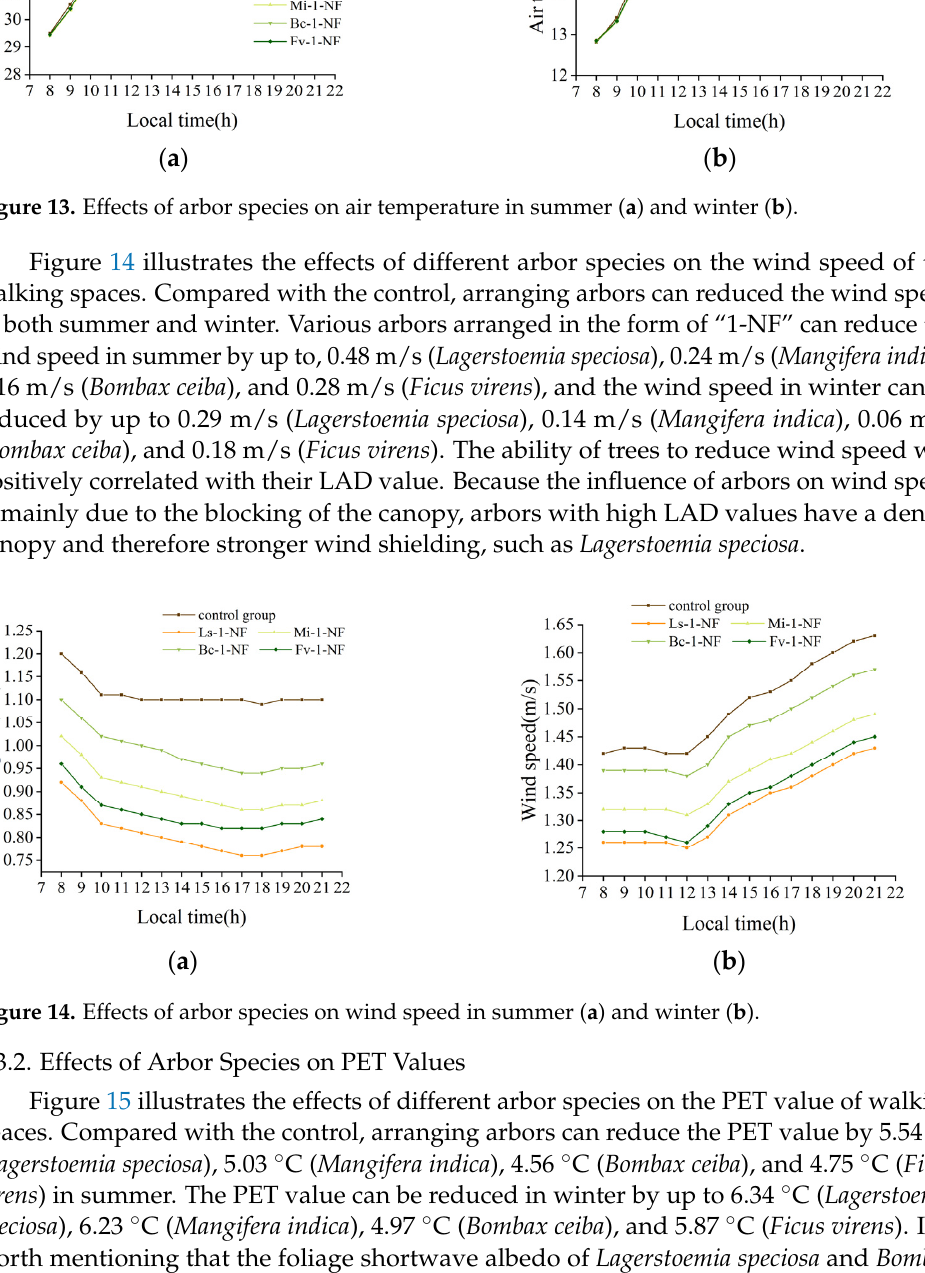
( b ) Figure 15. Effects of arbor species on outdoor thermal comfort in summer ( a ) and winter ( b ). 3.4. Effects of the Arrangement of Arbors on the Thermal Conditions of Different Walking Spaces Based on the above results, arranging Lagerstoemia speciosa on the lawn has the great- est impact on the outdoor thermal environment of the surrounding walking space. There- fore, the “Ls-1-NF” scenario was selected to compare the outdoor thermal environment differences of S1, S2, and S3 before and after planting Lagerstoemia speciosa.